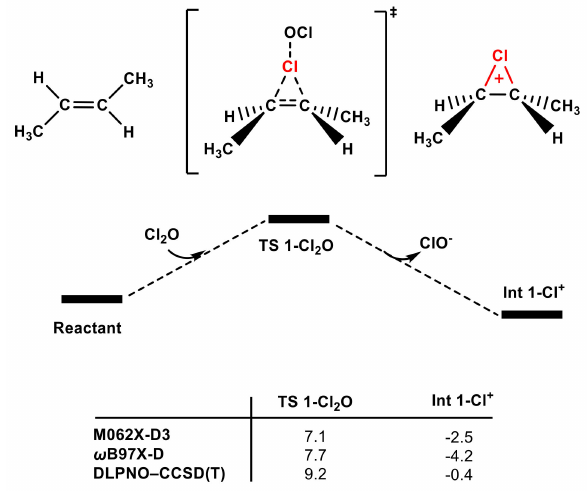
Figure 7. The partial PES of the reaction of Cl 2 O attacking trans-1,2-dimethyl ethylene (see SI for the whole PES). The Gibbs free energies of TS 1-Cl 2 O and Int 1-Cl + were obtained according to different methods (in kcal mol − 1 ).